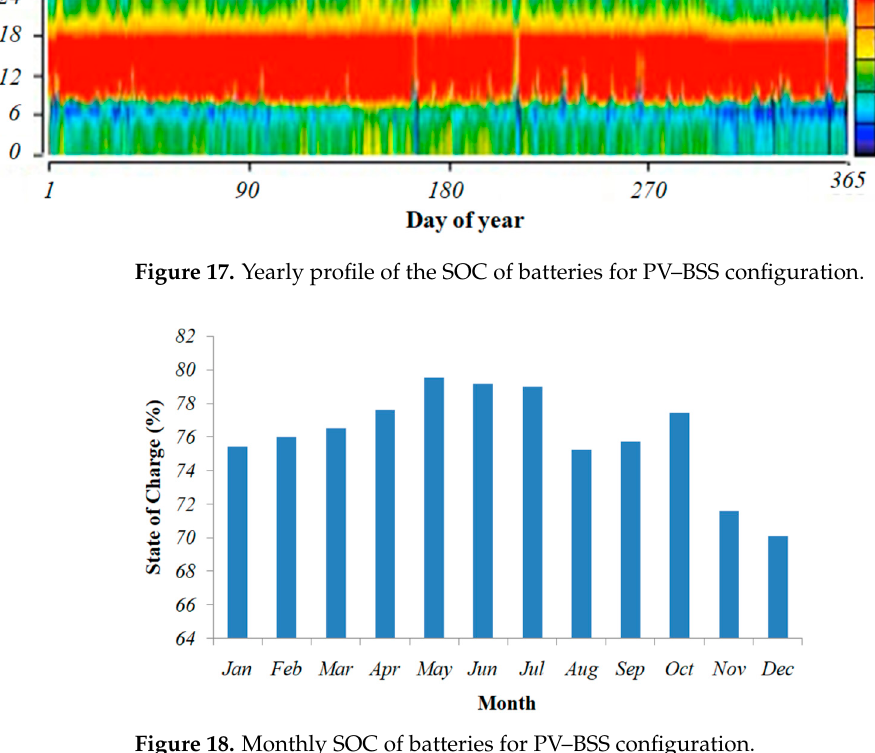
Figure 18. Monthly SOC of batteries for PV–BSS configuration.